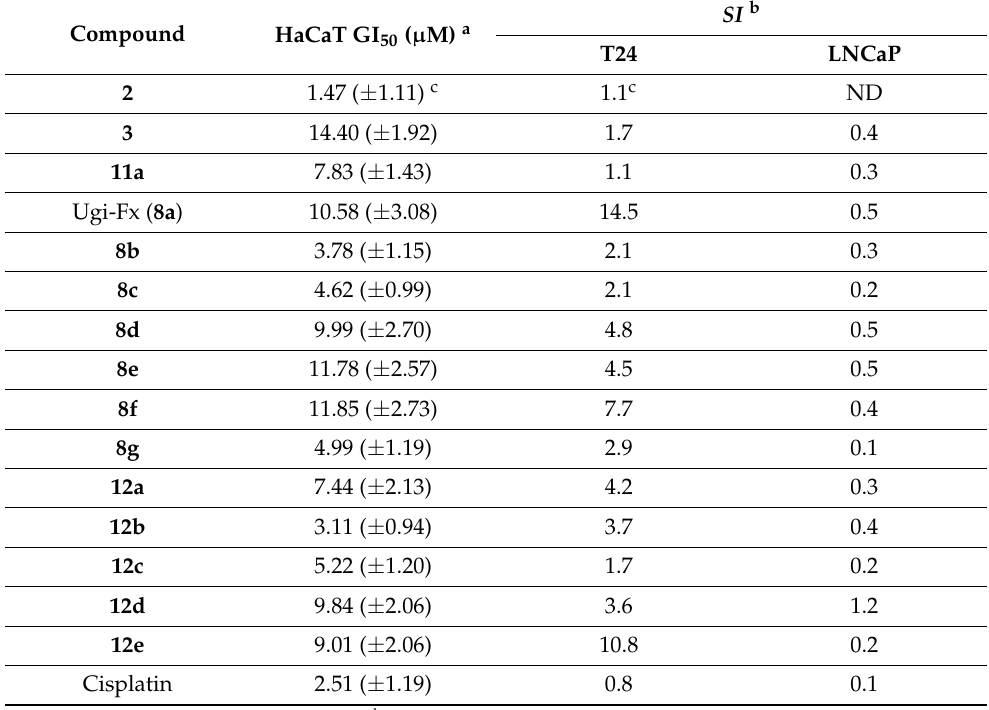
Table 3. Cytotoxicity of Ugi and GBB derivatives against HaCaT cells, along with selectivity indices.